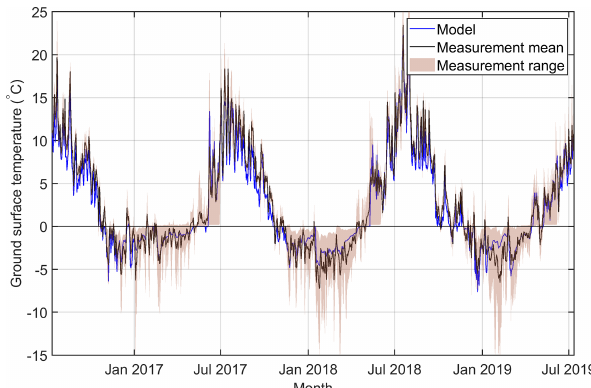
Figure 4. Daily modelled and measured ground surface tempera- tures in Ivarsfjorden from July 2016 to July 2019. The shaded area indicates the minimum to maximum range of measured daily values from 11 loggers (based on Lilleøren et al., 2022), while the black line represents the mean value of all